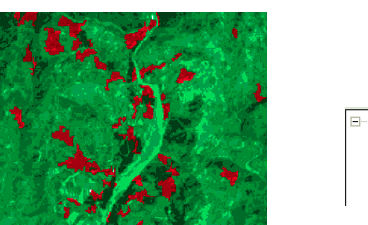
Figure 8. Landsat: fine segmentation